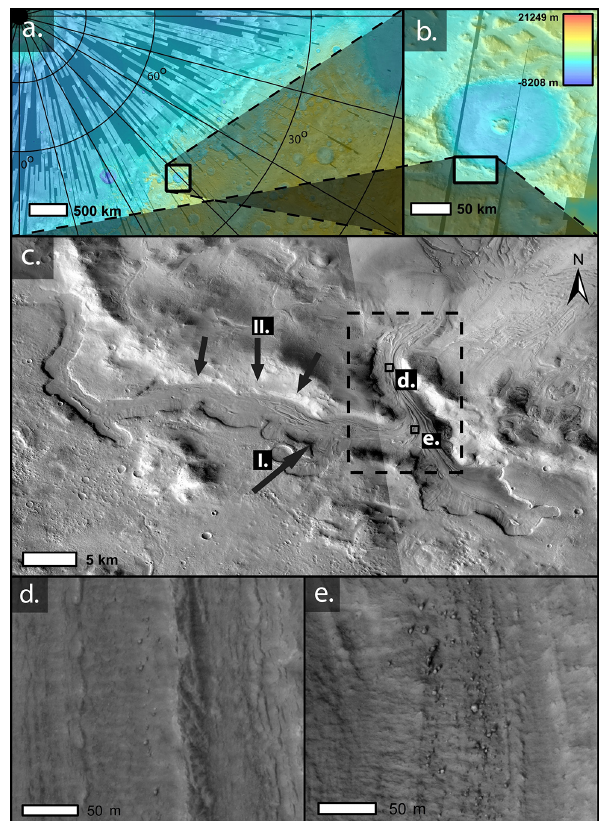
Figure 8. HiRISE image of GLF #498, located in Protonilus Men- sae showing background MOLA elevation images ( a and b ), and an expansion of GLF #498 (c) , along with two examples of surface boulder exposures ( d and e ). Arrows I. and II. on panel (c) indicate likely source areas for supra-GLF boulders illustrated in Fig. 9 and discussed in the text. The dashed box is expanded in Fig.